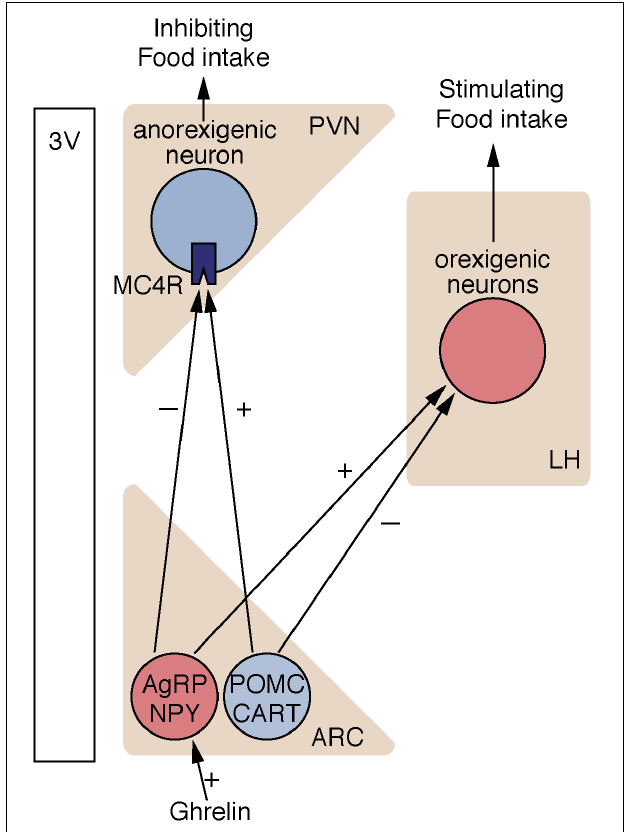
FIGURE 2 | Neural circuits controlling food intake. Nutritional information is integrated into ARC in the hypothalamus. In ARC, orexigenic neurons express NPY, and AgRP, whereas anorexigenic neurons express POMC and CART. SIRT1 is expressed in both AgRP neurons and POMC neurons in the ARC. ARC, arcuate nucleus; PVN, paraventricular nucleus; LH, lateral hypothalamic area; AgRP, agouti-related peptide; NPY, neuropeptide Y; POMC, pro-opiomelanocortin; CART, cocaine- and amphetamine-related transcript; 3V, third